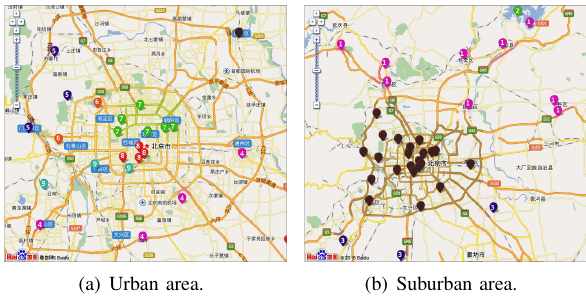
Fig. 7. Clustering results based only on IAQI. Map provide by Baidu.com, Inc.